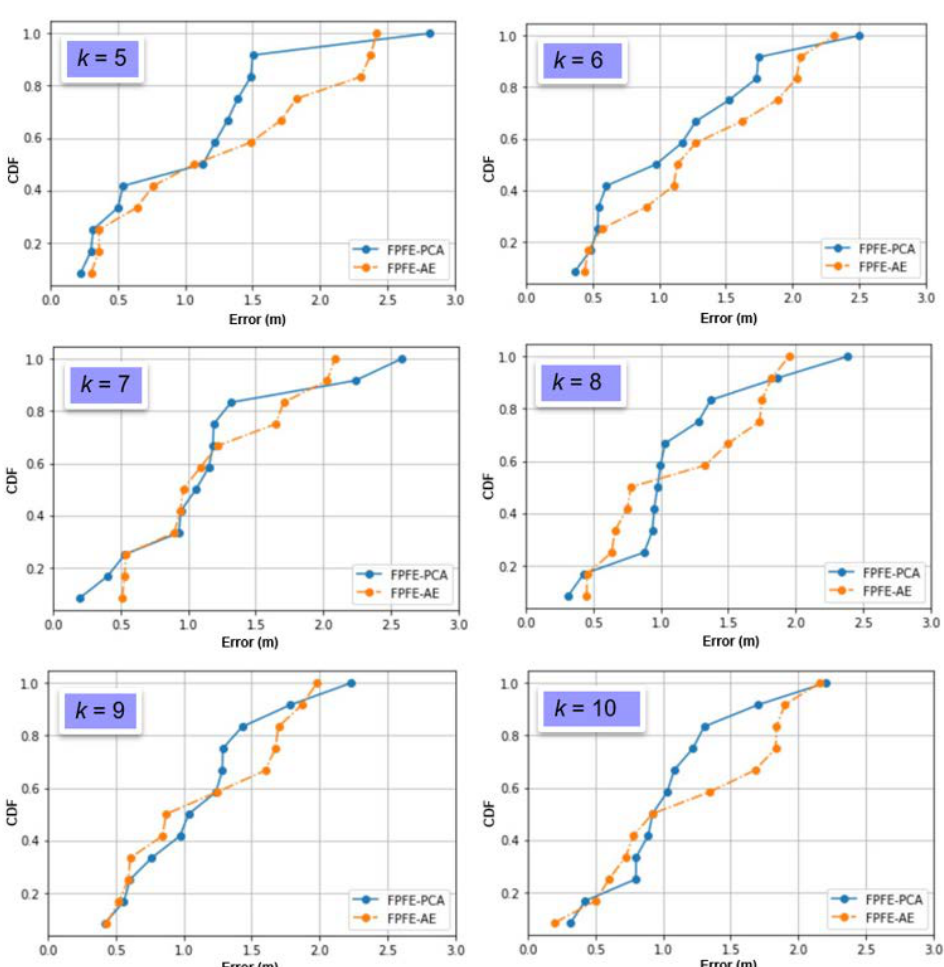
Figure 9. The localization error box-whisker plots of FPFE with 54 random RPs for k RP candidates, where k = 5, 6, 7, 8, 9, and 10.